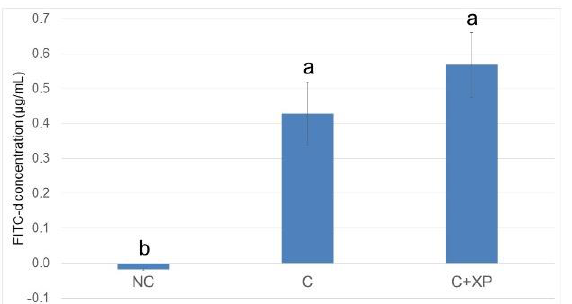
Figure 2. Fluorescein isothiocyanate dextran concentration (FITC-d, µg/mL) in serum of broiler chickens in response to feeding LFLP diet with or without enzyme supplementation (Expt. 2). Treatments with different letters are significantly different ( p < 0.05). N = 6. NC, unchallenged (no enzyme) treatment; C, challenged (no enzyme) treatment; C+XP, challenged and supplemented with xylanase and protease treatment. The error bars represent the SEM values.